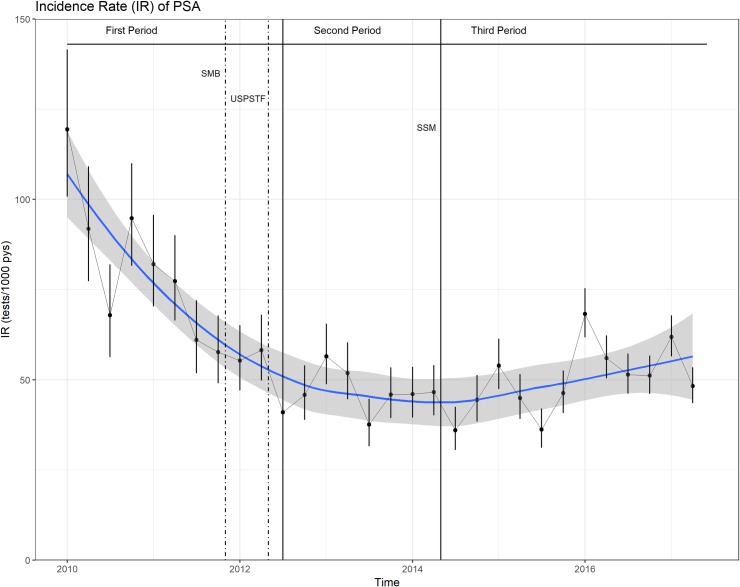
Incidence rate of PSA (observed).Fig 2 shows the observed Incidence rates of PSA screening (tests per 1000 patient-years). Points represent incidence rates calculated by quarters. Error bars represent 95% confidence intervals. The blue line represents the smoothing and the gray area represents the 95% confidence interval band. Solid vertical lines identify the three time periods. Dotted lines identify the date of important publications. Abbreviations: IR = incidence rate, pys = patient-years, SMB = Swiss Medical Board recommendation, USPSTF = United States Preventive Services Task Force recommendation, SSM = Swiss Smarter Medicine campaign.